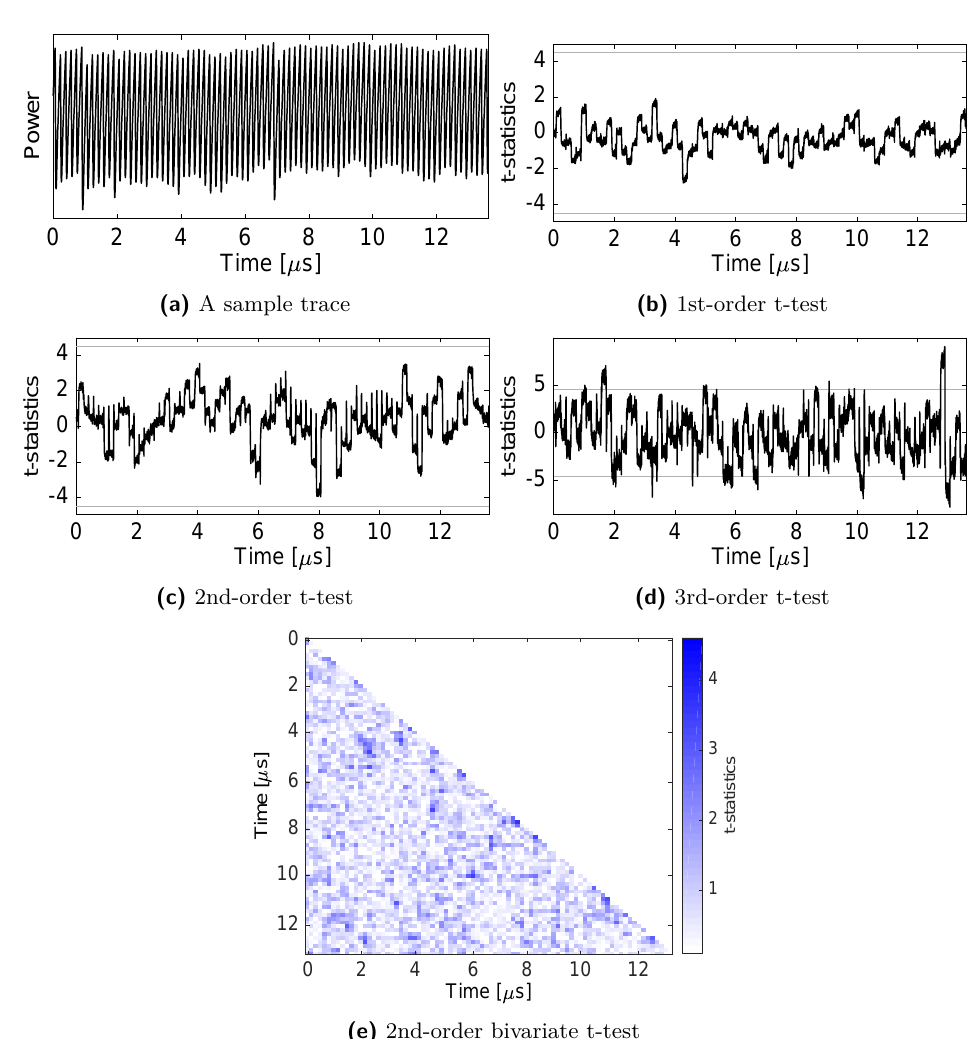
Figure 12: Experimental analysis of the masked Prince from Section 5.4 using 100 million